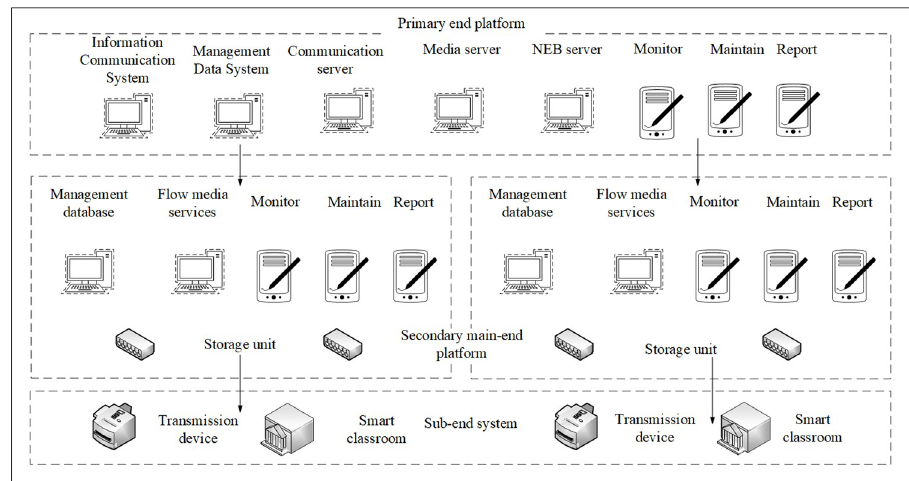
Fig 6. The overall topology of the integrated platform of the smart classroom teaching